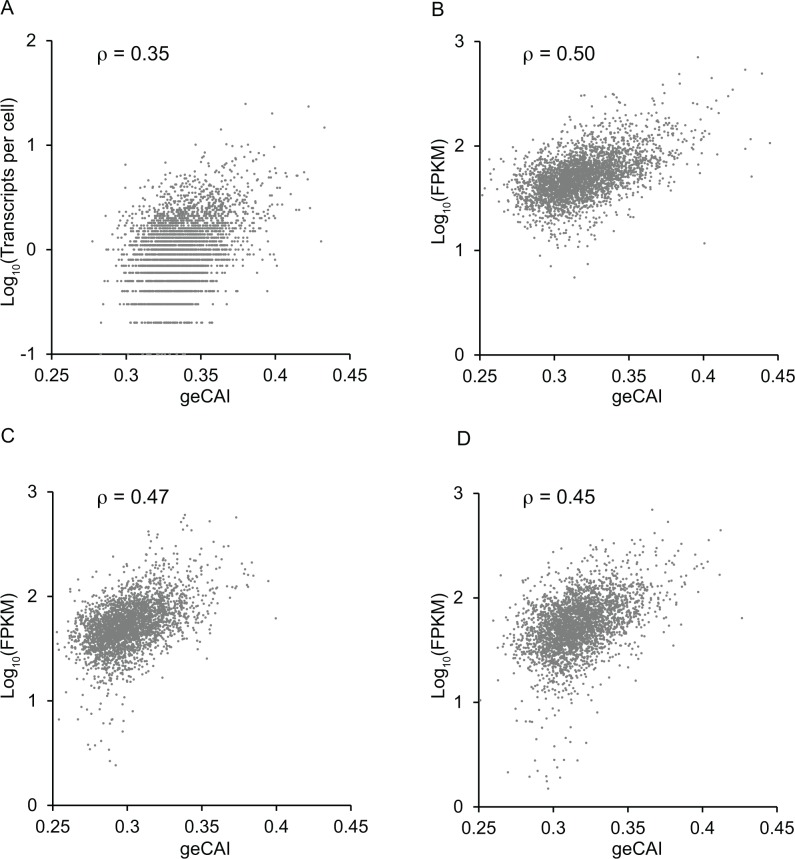
Correlation between mRNA expression levels and geCAI scores calculated from transcriptomes from other studies (Fadda et al., 2014; Christiano et al., 2017; Hutchinson et al., 2016).In each case the transcriptome data was used to calculate a table of geCAI values for each codon (Supplementary file 5B). The score for each ORF was then plotted against the measured mRNA abundance: (A) reference (Fadda et al., 2014) PCF; (B) reference (Christiano et al., 2017) PCF; (C) reference (Hutchinson et al., 2016) BSF; (D) reference (Hutchinson et al., 2016) PCF. The Spearman’s rank correlation coefficient is given as ρ at the top of each graph.